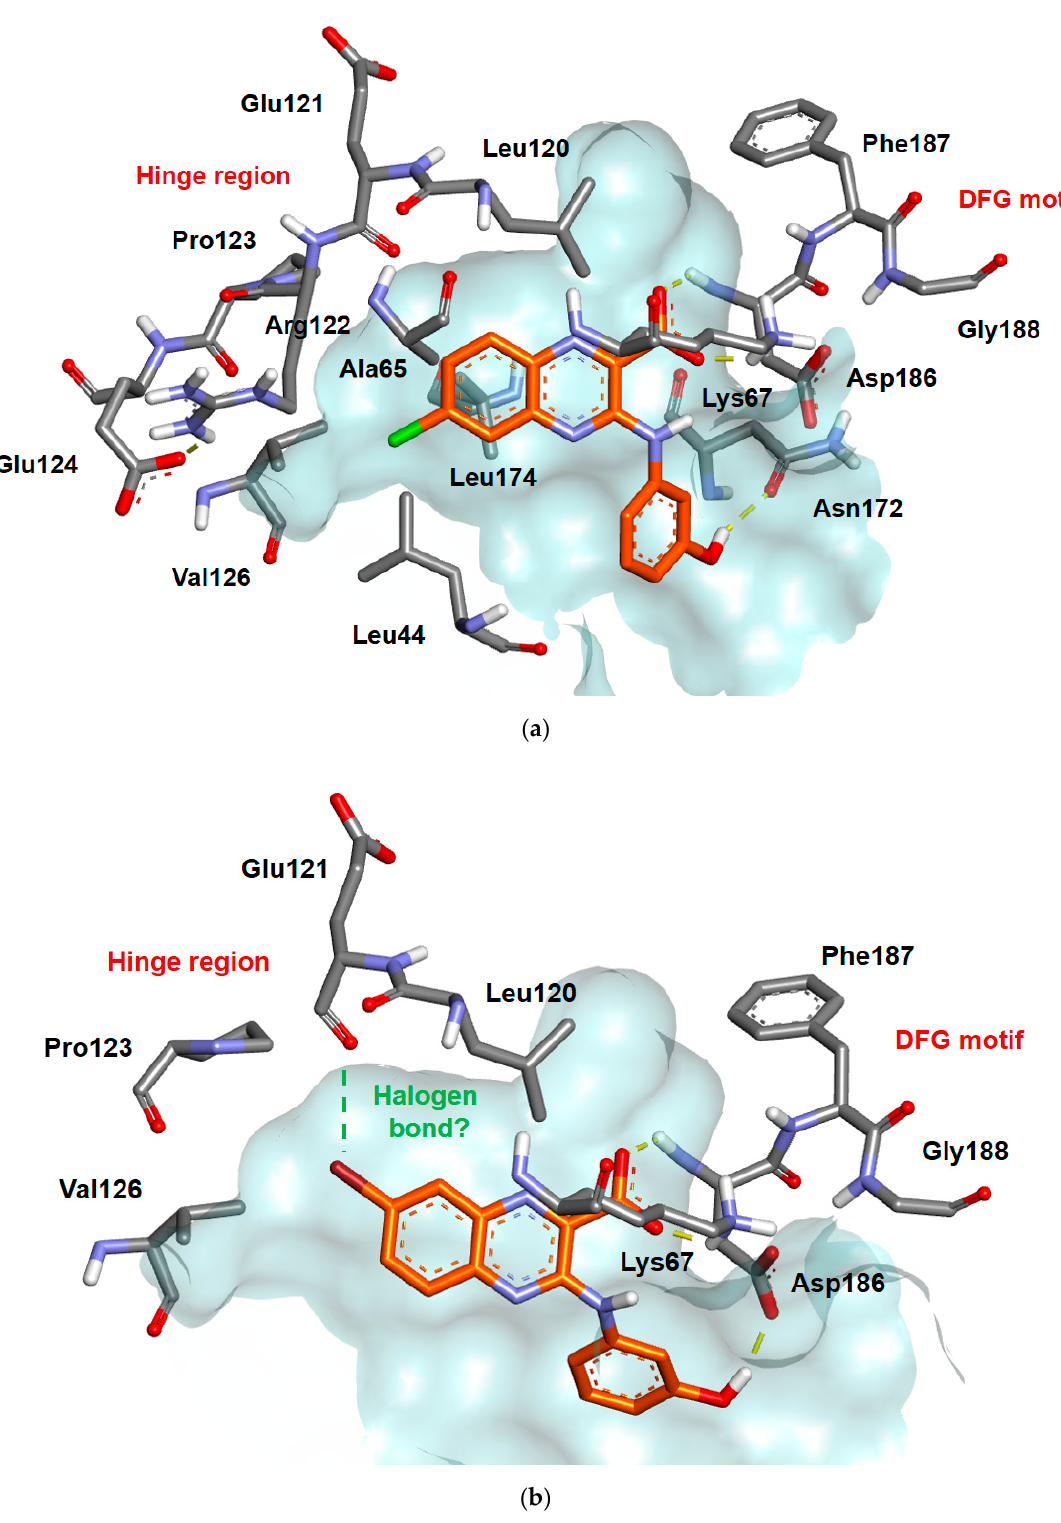
Figure 4. ( a ) Illustration of the possible binding mode within the ATP pocket of Pim ‐ 1 of compound 5c ( b ) Illustration of the possible binding mode within the ATP pocket of Pim ‐ 1 of compound 5f . Hydrogen bonds are indicated as yellow lines. Pim ‐ 1 PDB ID: 3A99.